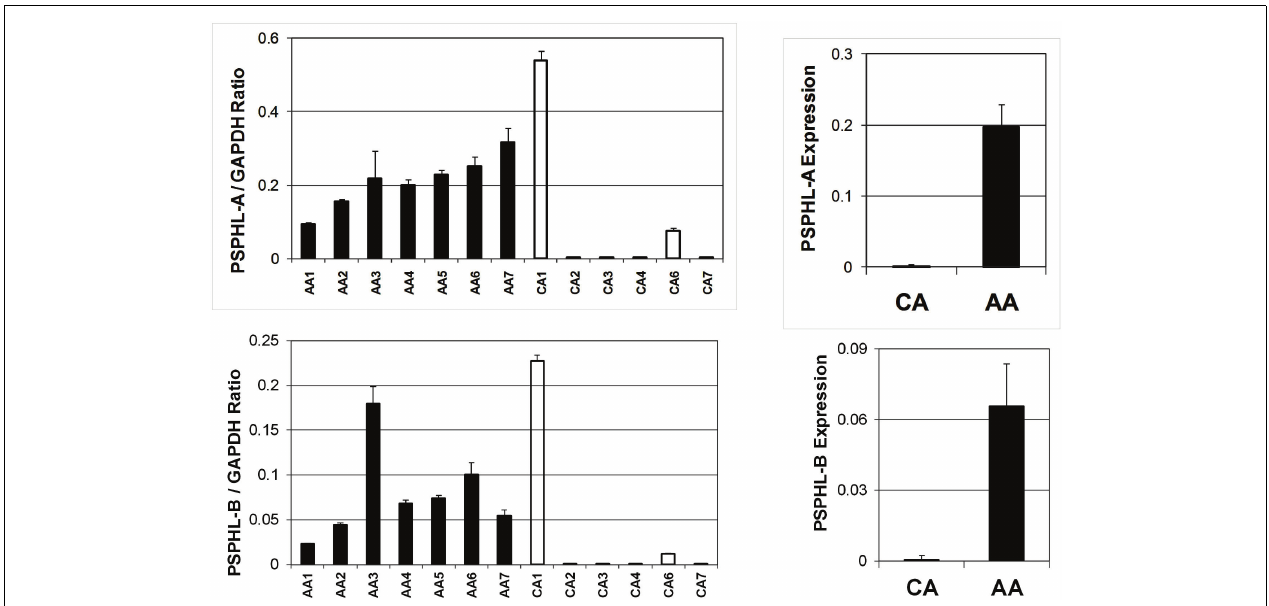
FIGURE 7 | Relative expression levels of PSPHL-A (top) and PSPHL-B (bottom) in normal endometrium for Caucasian andAfrican-American women. Left: individual cases; Right: averages. PSPHL-A: AA/CA ratio=279, p =0.007; PSPH:L-B AA/CA ratio=146, p =0.0065.